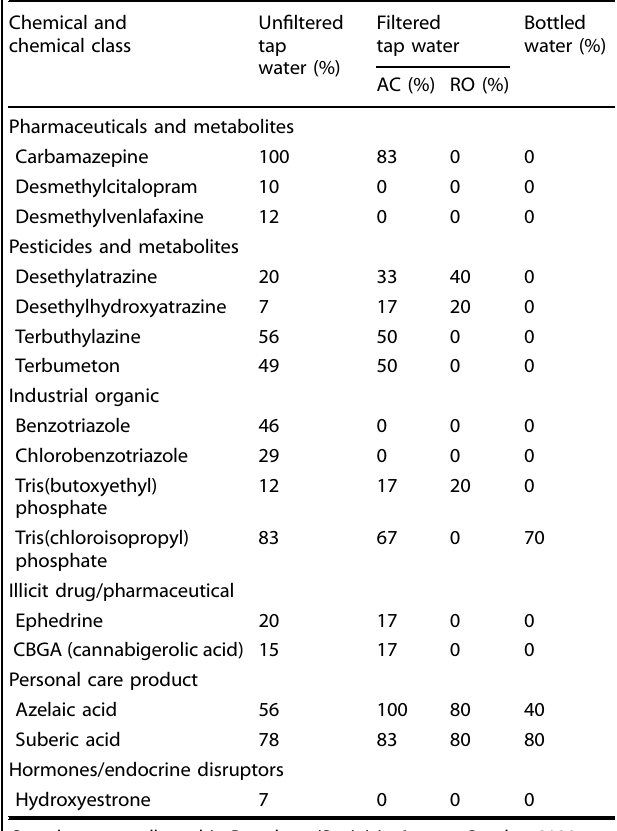
Table 3. Occurrence frequency (%) of chemicals tentatively identi fi ed osmosis (RO, N = 5), and bottled water samples ( N =